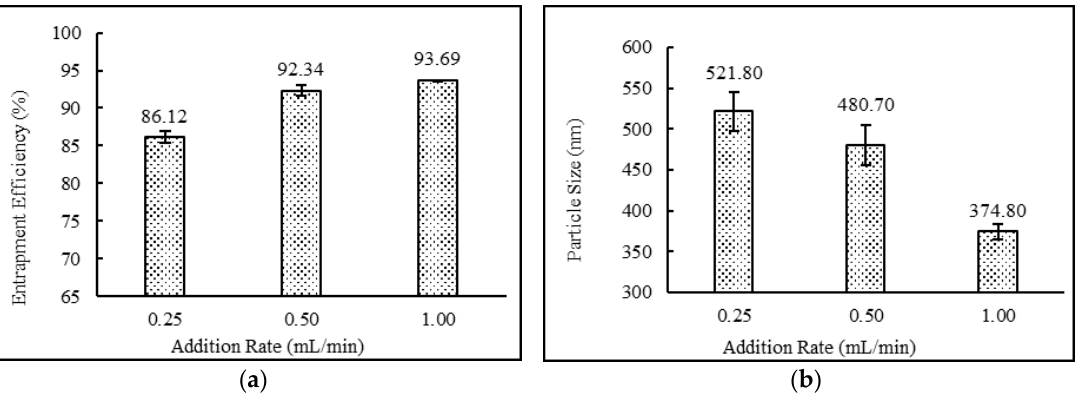
Figure 6. E ff ect of addition rate (ml / min) on ( a ) entrapment e ffi ciency (%) and ( b ) particle size (nm) of Figure 6. Effect of addition rate (ml/min) on ( a ) entrapment efficiency (%) and ( b ) particle size (nm) niosomes. ( N = 3, mean ± of niosomes. ( N = 3, mean ± SD).